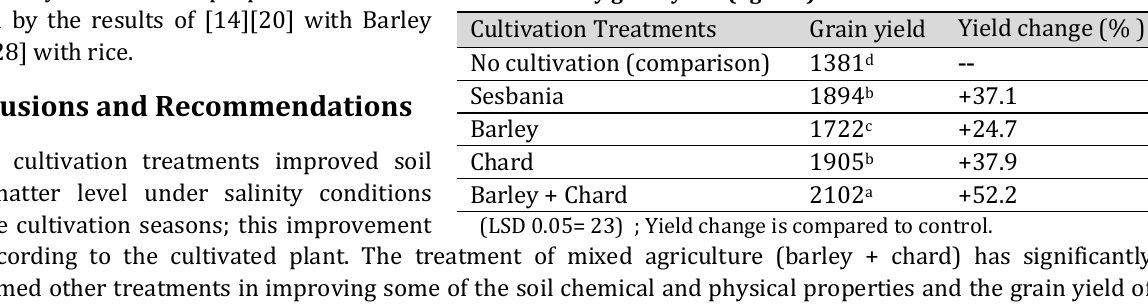
Table 4 . Effect of incorporati ng of th e cultivation residue s in